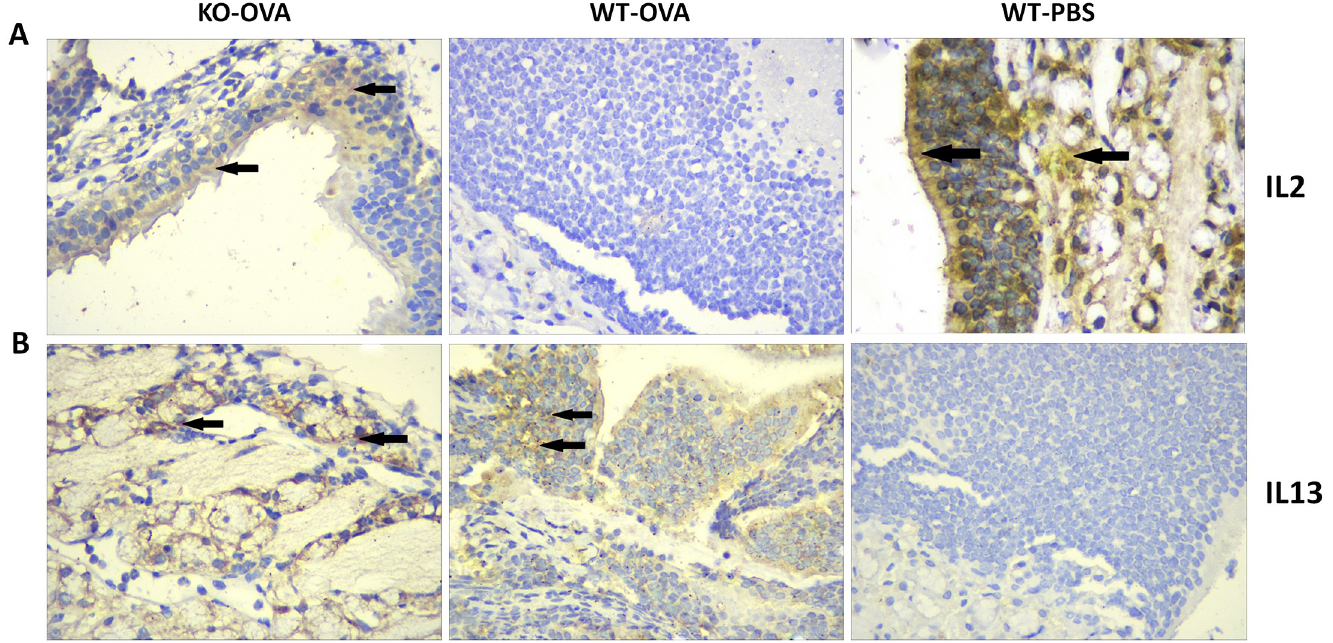
Fig 5. The expression of IL-2 and IL-13 in the nasal mucosa of different groups of mice, as detected by IHC. The panels in A show the IL-2 staining in the different groups, while the panels in B show the IL-13 staining in these groups. The arrows indicate highly positive areas.